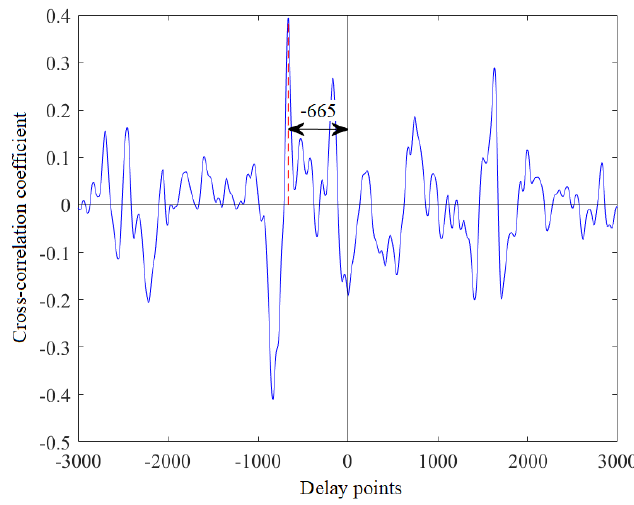
Figure 12. Cross-correlation analysis of the abnormal